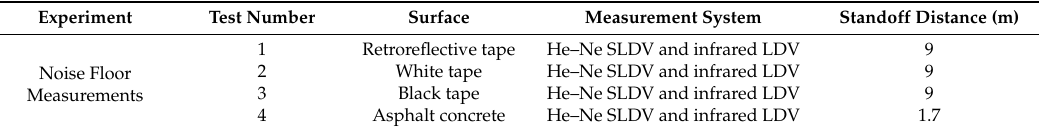
Figure 2. Second experiment: modal analysis on a pavement plate with two different scanning laser Doppler vibrometer (SLDV) systems. Table 1. First experiment: noise floor measurement of two He–Ne and infrared laser Doppler vibrometers on four different surfaces.